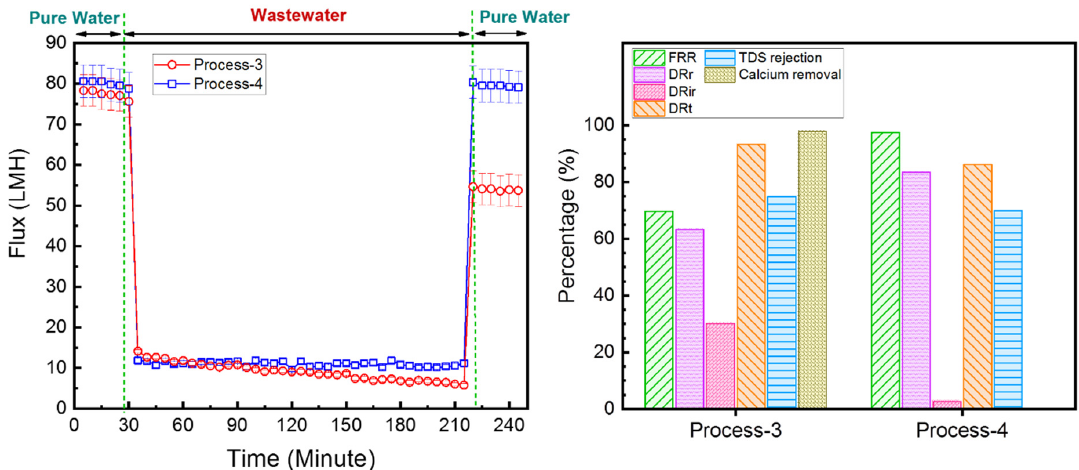
Figure 5. Permeation flux and fouling characteristics of process-3 and 4, which involved chemical pre-treatment followed by nanofiltration. Transmembrane pressure is set to 250 psi and operating temperature of 25 °C.